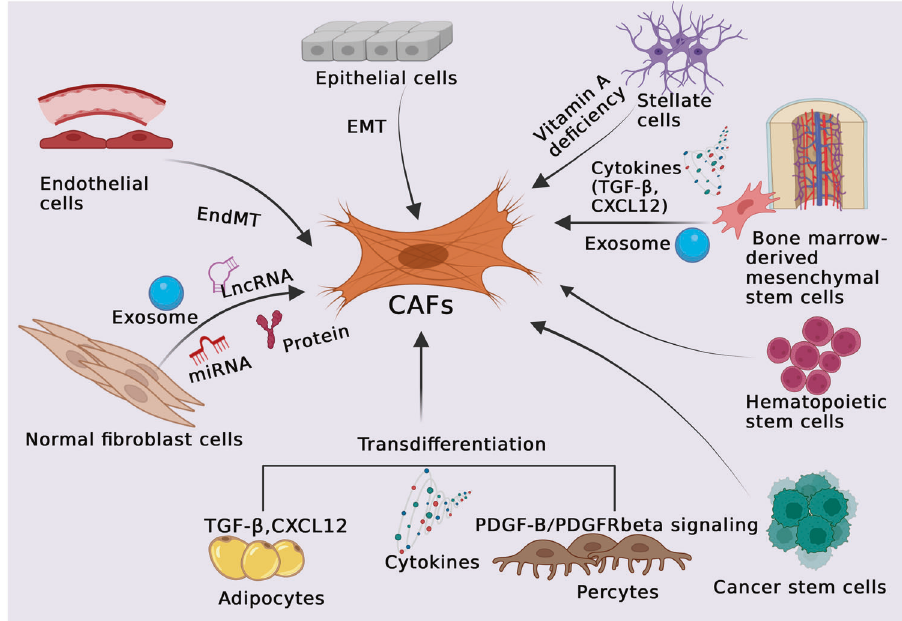
Fig. 1 Origin heterogeneity of CAFs. CAFs comprise a complex and heterogeneous group of cells. This heterogeneity might be attributed to the diversity of CAF origins. Numerous cells can be activated and recruited as CAF precursors, such as (1) NFs, (2) epithelial cells (through the epithelial-mesenchymal transition; EMT), (3) endothelial cells (through the endothelial-mesenchymal transition; EndMT), (4) peritumoral adipocytes, (5) pericytes, (6) hematopoietic stem cells, (7) bone-marrow-derived mesenchymal stem cells (BMSCs), and (8) cancer stem cells. It has been indicated that NFs can be educated and further transformed into CAFs through cytokine and chemokine activation in GC. Furthermore, CAFs can also arise from cancer stem cells, hematopoietic stem cells, and